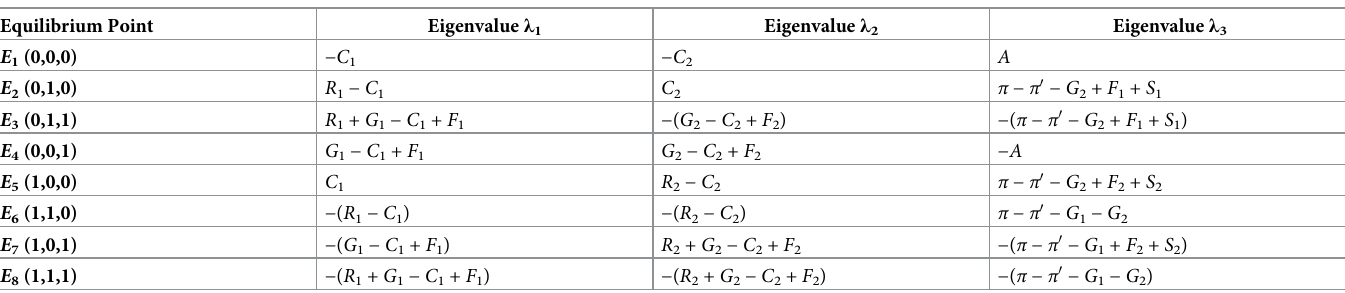
Table 3. Eigenvalues of Jacobian matrix of PPSWPTPP.